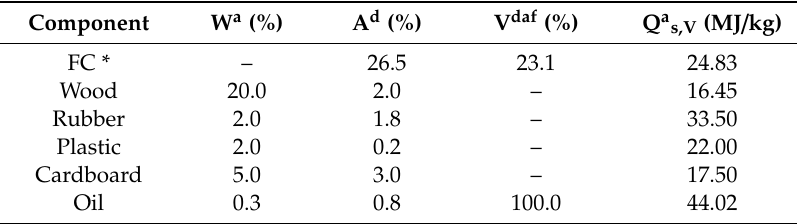
Table 3. Characteristics of fuel components: Proximate analysis [16,29].